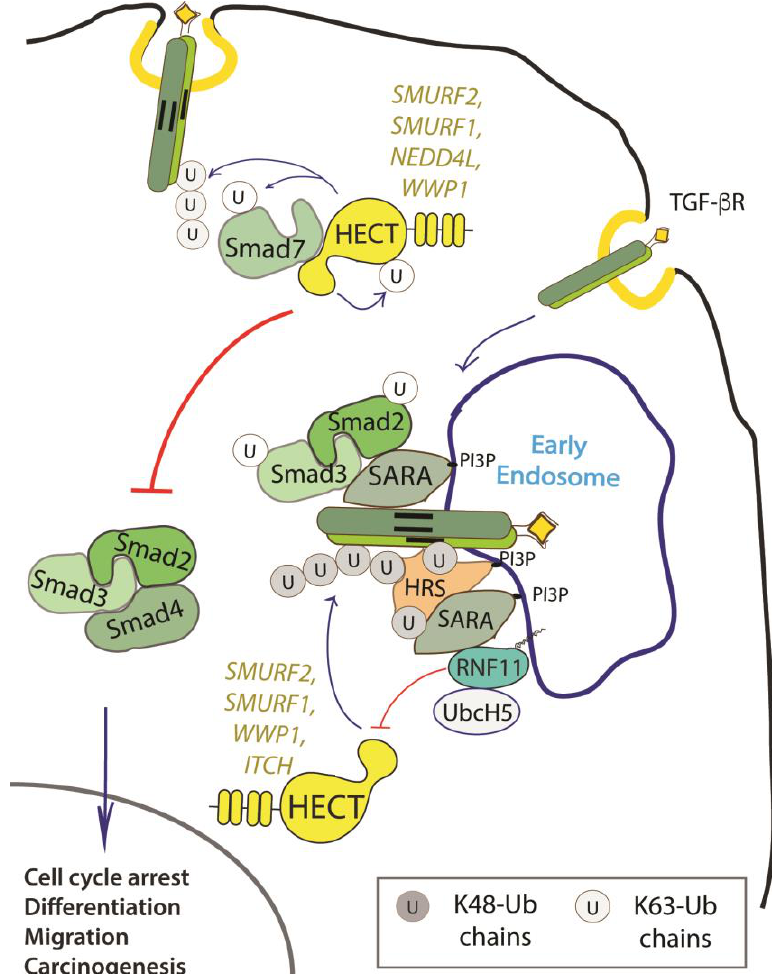
Figure 2. Role of RNF11 in the transforming growth factor beta (TGF- β ) signaling pathway. Following ligand binding, the ubiquitination of the TGF-b receptor promoted by the SMURF2-SMAD7 E3 ligase complex targets the receptor to the lysosome or the proteasome for degradation. From the early endosomes, the TGF-b receptor can be sorted to recycling endosomes and return back to the cell surface or it can be driven to late endosomes and lysosomes for degradation. The activated receptor complex recruits and phosphorylates the receptor-regulated SMAD (R-SMADs, e.g. SMAD2 and SMAD3). Association of TGF-b receptors with early endosomes adaptor proteins such as SMAD anchor for receptor activation (SARA), leads to the enhancement of TGF-ß -induced SMAD activation and the subsequent propagation of SMAD-dependent signaling. Activated R-SMADs dissociate from the TGF- β receptors and associate with Smad4, a common-partner for all R-Smads (Co-SMAD). These complexes translocate into the nucleus where they regulate transcription of TGF-b family target genes by binding transcriptional factors, transcriptional coactivators and corepressor. Posttranslational modifications of SMAD proteins, among which ubiquitination by NEDD4 family of E3-ligases, provide an additional level of regulation of the TGF- β signaling, controlling protein stability and function.